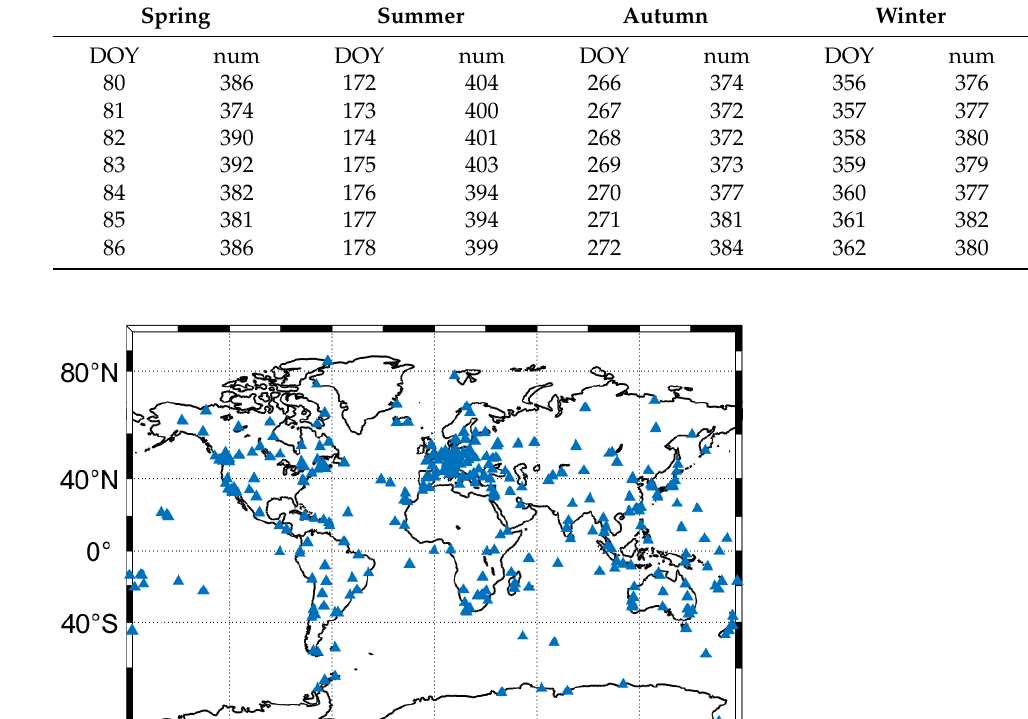
Table 4. The corresponding day of year (DOY) and the number of global International GNSS Service (IGS) GPS stations (num).